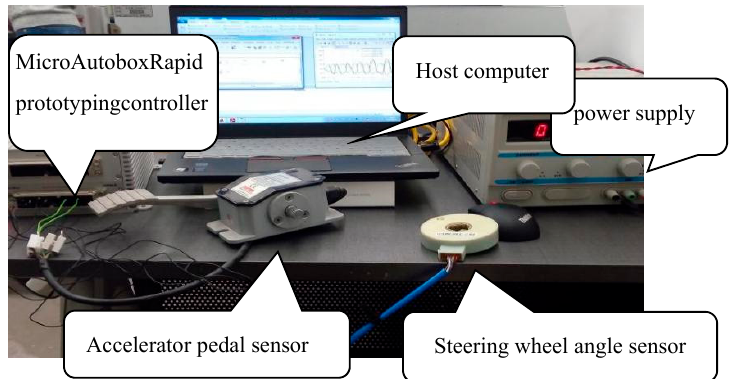
Figure 11. Stability experiment platform based on dSPACE.